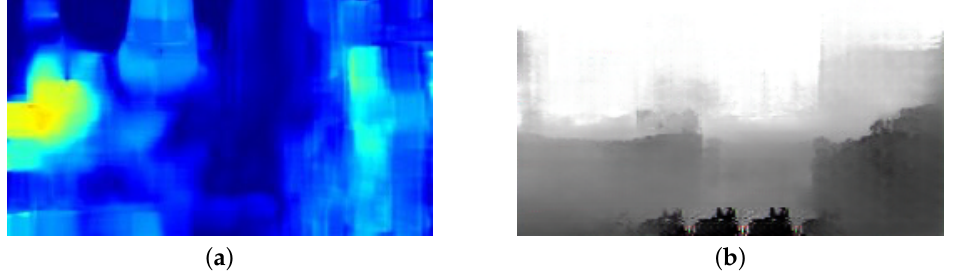
Figure 13. Input and Output of Optical Flow Model: ( a ) Input, ( b ) Output.